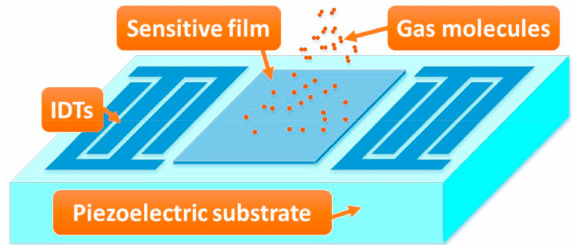
Figure 1. The schematic of the surface acoustic wave (SAW) gas